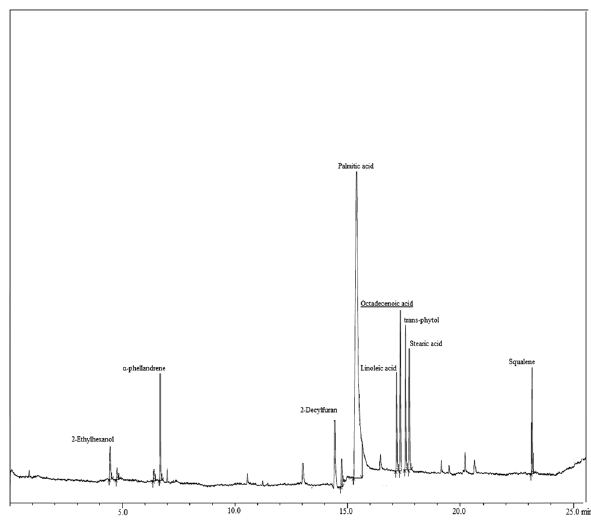
Figure 2: GC - MS pro fi le for PE extract of Curcuma longa